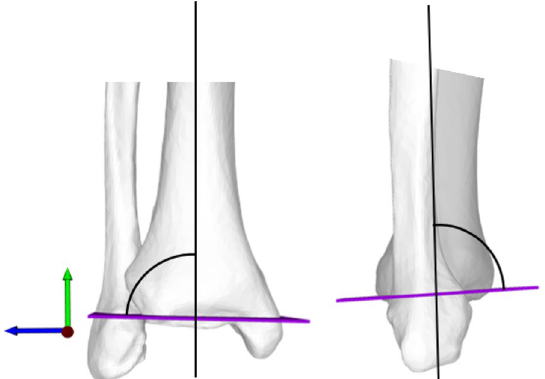
Fig. 4 Lateral distal tibial angle (LDTA) and anterior distal tibial angle (ADTA) and Left: LDTA measured as projected 2D angle in frontal plane (plane normal red arrow). ADTA measured as projected 2D = angle in sagittal plane (plane normal blue =